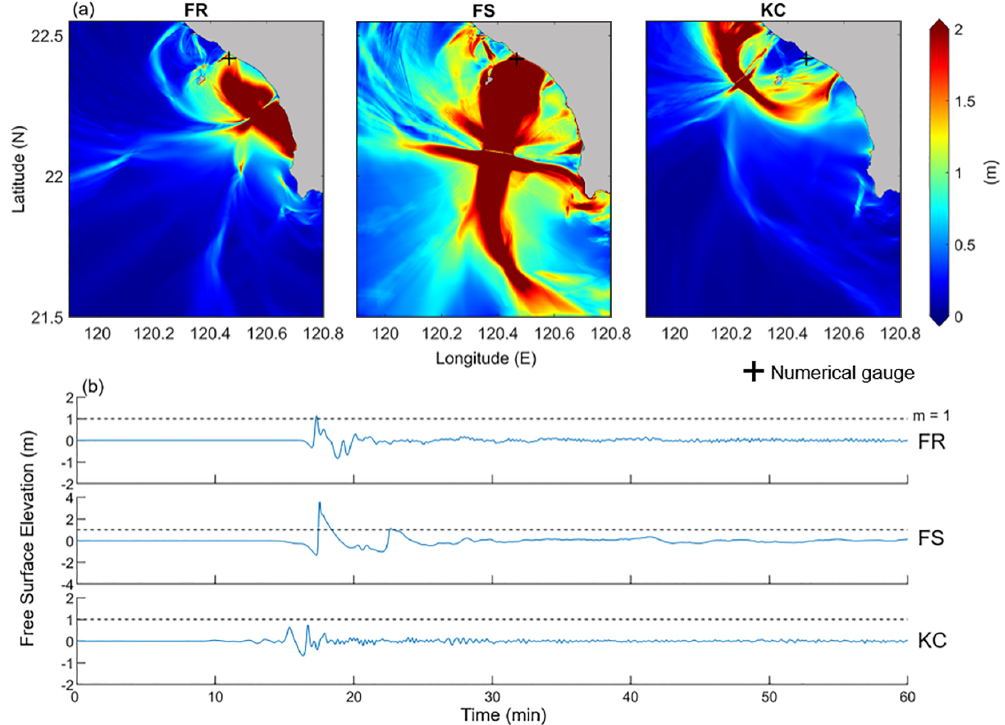
Figure 6. (a) Maximum wave height of the 1781 SMF tsunami simulations. The black cross denotes the numerical gauge of Jiateng Harbor (22.417 ◦ N, 120.467 ◦ E). (b) Numerical gauge records at the Jiateng Harbor study site for the SMF scenarios of FR, FS, and KC. The 1m elevation is marked with dashed lines for